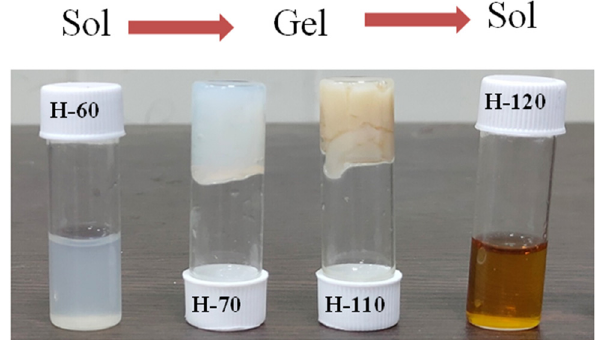
Figure 1: Di ff erent phases of developed BSA hydrogel at di ff erent